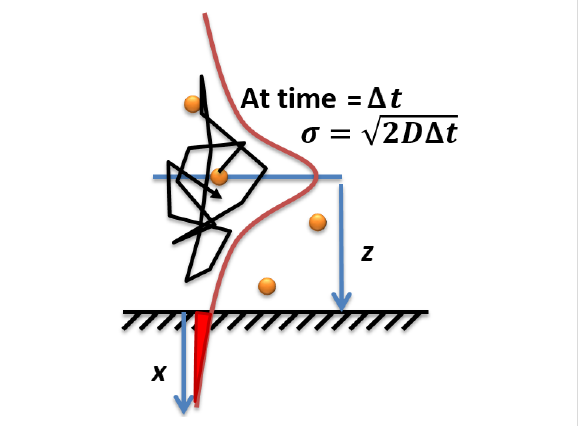
YOYO-1 in water is ≈ 2.9 × 10 − 10 m 2 s − 1 . The area of 1 μ m of Figure 9: Scheme of molecular diffusion in the solution.